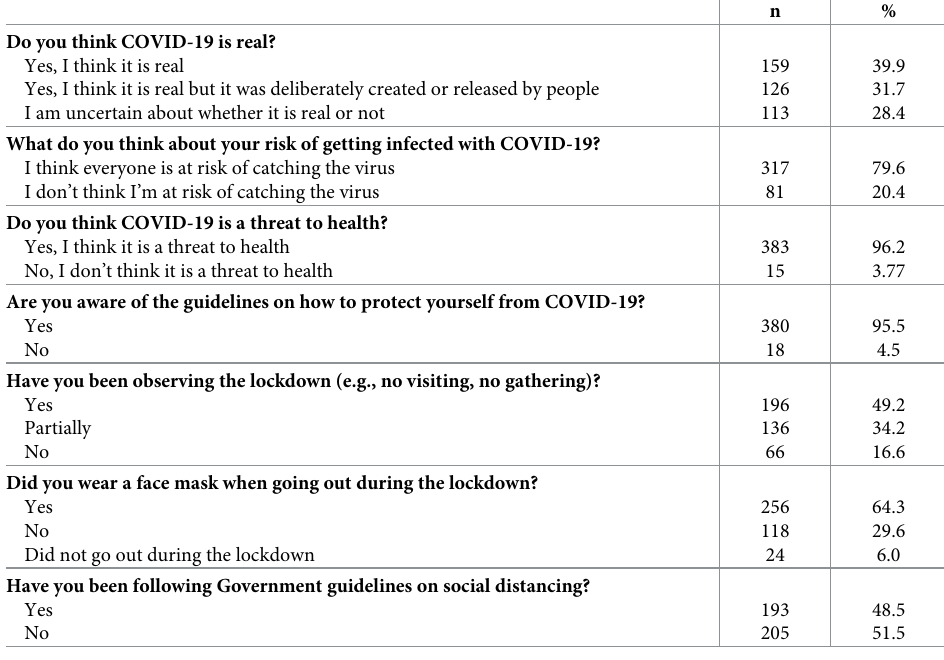
Table 2. Perceived risks of COVID-19 and attitudes towards preventive